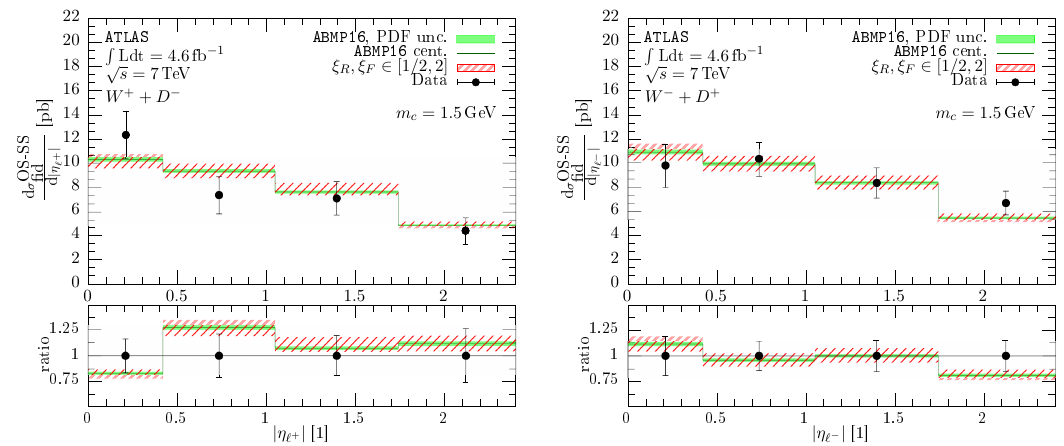
Figure 9 . Difference of the differential cross-section for W + D -meson production, with W ± → ( − ) ‘ ± + ν ‘ , where the ‘ ± and the D ± -meson have charges of opposite sign and that where the ‘ ± and the D ± -meson have charges of same sign, as a function of the absolute value of the pseudorapidity of the ‘ ± . Theoretical predictions at NLO + SMC accuracy, obtained by PowHel + PYTHIA8 are compared to experimental data from the ATLAS collaboration [21]. 7-point ( µ R , µ F ) scale and PDF uncertainty bands, computed from the 30 members of the ABMP16 PDF set, are reported by shaded (red) and solid (green) bands, respectively. The predictions include parton shower, hadronization, MPI and beam remnant effects according to the PYTHIA8 ATLAS A14 central tune with NNPDF2.3LO PDFs.